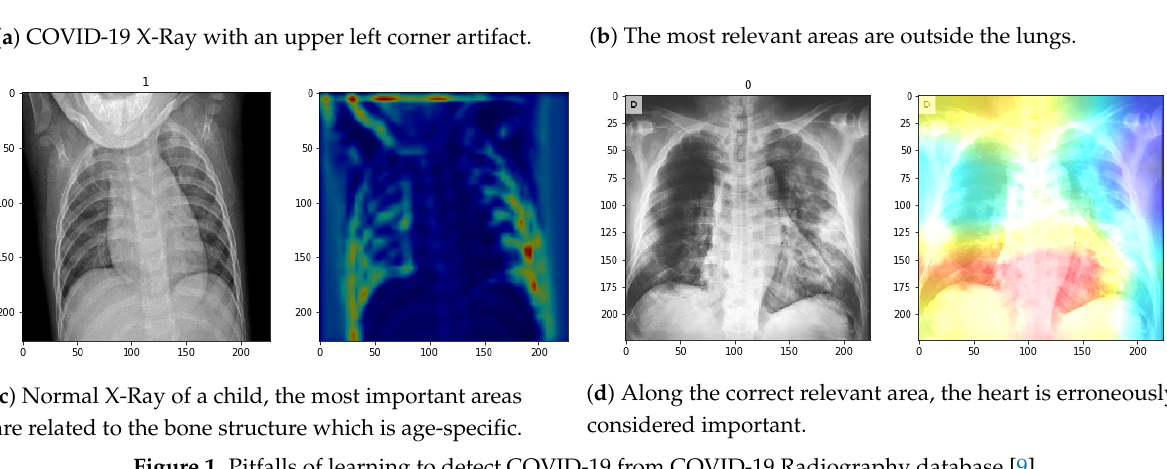
Figure 1. Pitfalls of learning to detect COVID-19 from COVID-19 Radiography database